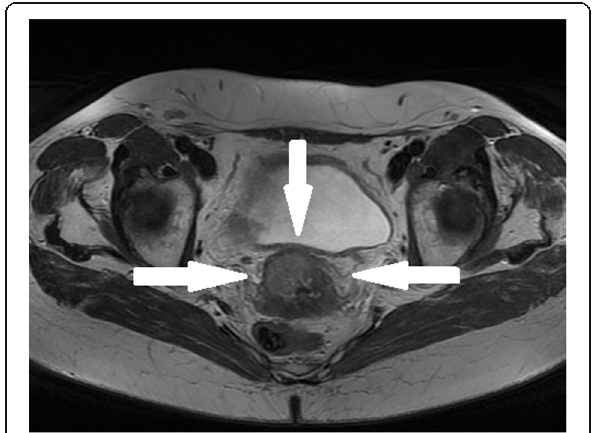
Fig. 1 Magnetic resonance imaging showing a polypous tumor in anterior labium region of the cervix, with the size of 26x24x23mm, without parametrial infiltration, without lymphadenopathy